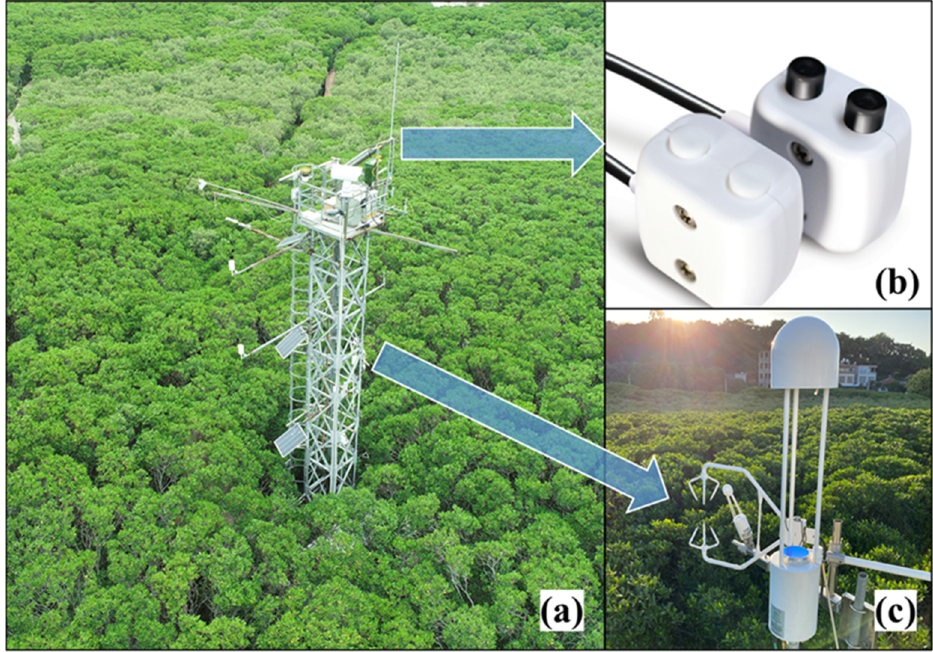
Figure 1. The landscape around the mangrove flux tower ( a ) with spectral ( b ) and eddy covariance systems ( c ) deployed on the tower.